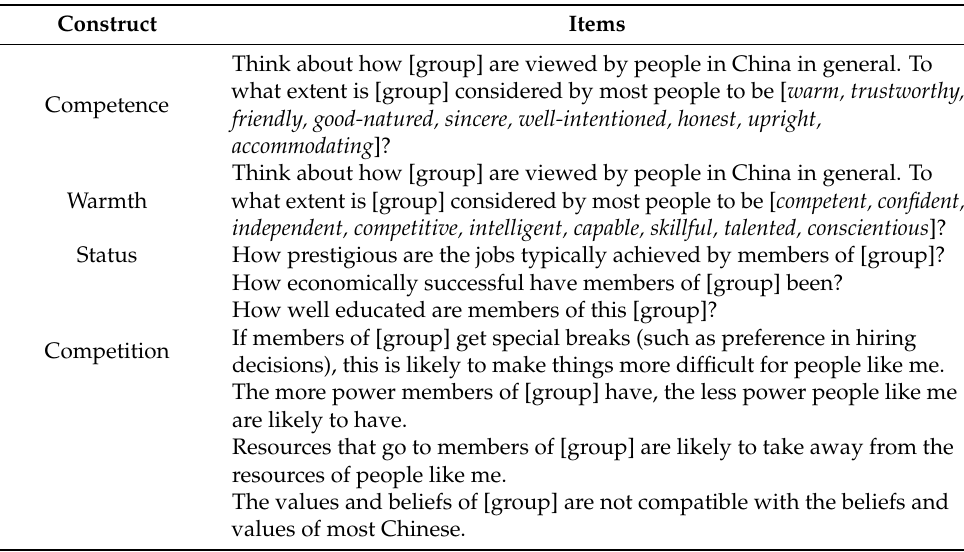
Table 3. Scale items for competence, warmth, status and